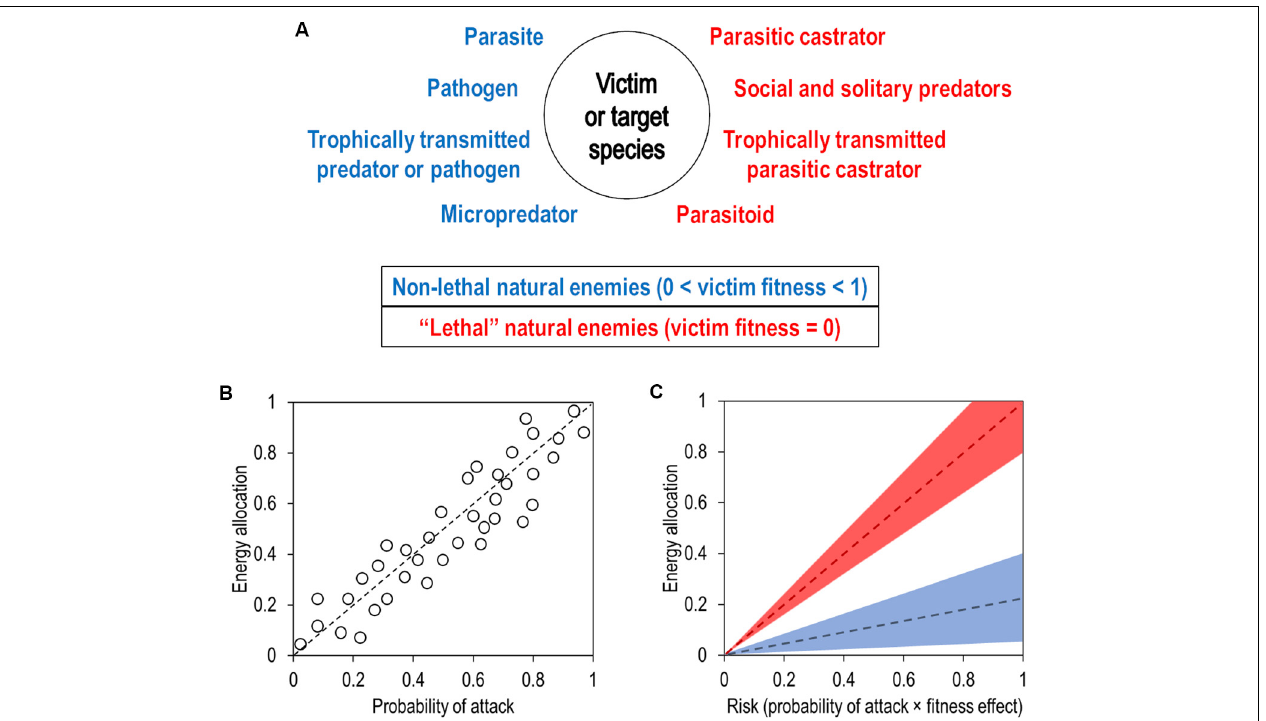
FIGURE 1 | How animal victims may evolve to allocate energy toward avoidance behaviors against natural enemies. (A) Ten recognized trophic strategies in natural enemies toward victims. “Lethal” natural enemies do not necessarily kill their victims, but effectively eliminate victim fitness. The dichotomy between lethal and non-lethal natural enemies represents one of the evolutionary pressures to evolve avoidance behaviors. (B) Theoretical evolution of energy allocation toward avoidance behaviors based solely on the probability that a victim will be attacked by a natural enemy during its lifetime. Each circle represents one victim population that evolves with a certain probability of being attacked by a natural enemy. (C) How victim populations theoretically evolve to allocate energy toward avoidance behaviors under the risk imposed by natural enemies. Risk results from the product of the probability of attack multiplied by the fitness cost imposed by a certain natural enemy. Therefore, in the case of victims that evolve exclusively with lethal natural enemies (red dashed line), the risk imposed by the latter equals to the probability of being attacked. With victims that evolve exclusively with non-lethal natural enemies (blue dashed line), the risk can range from anywhere between 0 and 1, depending on the fitness cost imposed by the natural enemy (in this case, the fitness cost is 0.2). The colored areas represent a plastic response of resource allocation, whereas the dashed lines represent a fixed